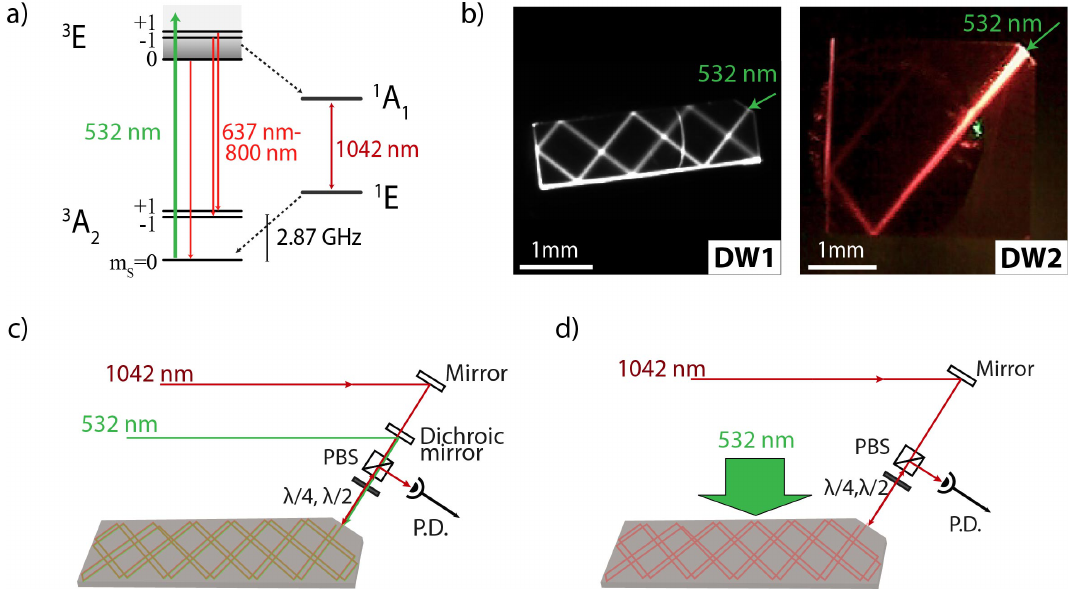
Figure 1. ( a ) Energy-level diagram of the negatively-charged nitrogen-vacancy (NV) color center in diamond. ( b ) Photographs of two different diamond waveguide (DW) crystals used in our experiments, excited by a pump (532nm) laser (with a power of ≈ 100mW) showing bright fluorescence (a long-pass filter with a 600nm cut-off wavelength is used to record these images). Schematic of infrared (IR)-absorption magnetometric setup for two different configurations: ( c ) the pump beam is overlapped with the IR beam within the waveguide geometry; ( d ) the pump beam is focused through the side of the diamond waveguide allowing for uniform illumination of the waveguide, which ensures maximum spatial overlap between the IR and the pump